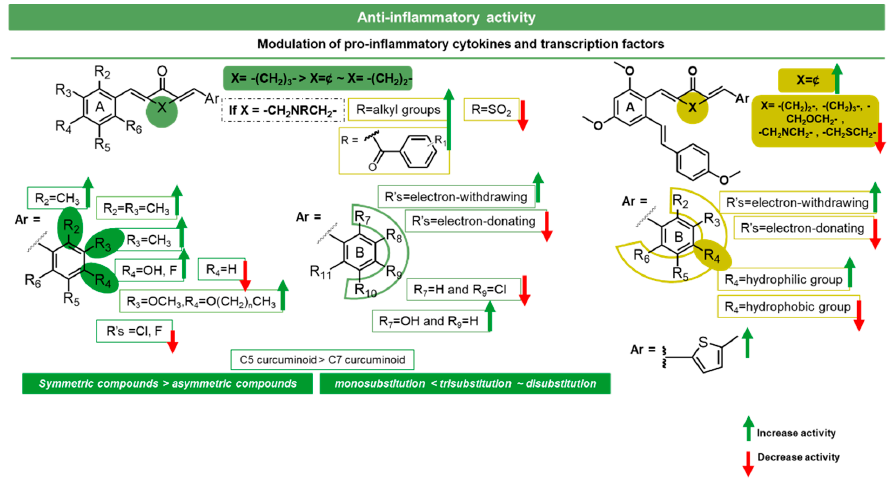
Figure 11. Putative SAR for the effects of diarylpentanoids on the modulation of pro-inflammatory cytokines and transcription factors.